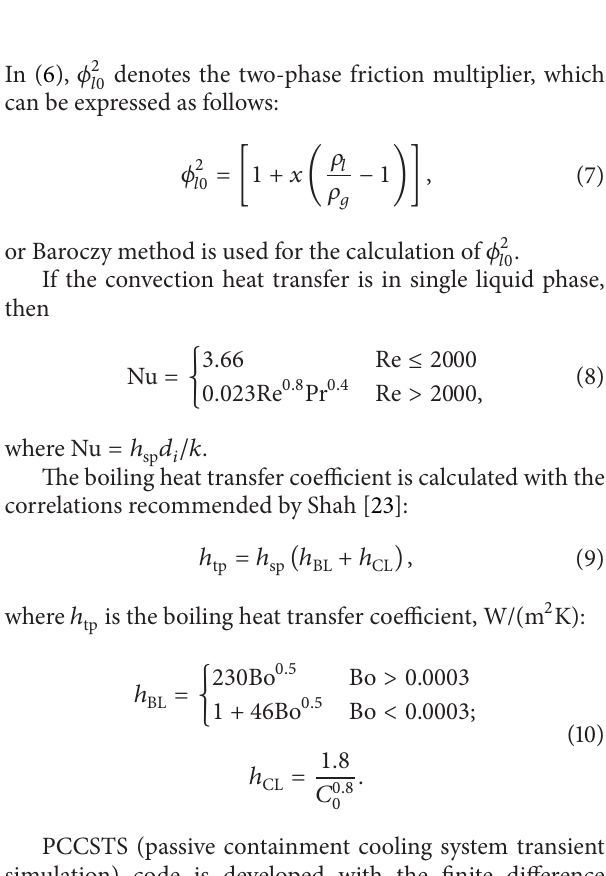
Figure 1: Schematic of OLPCCS (not to scale).